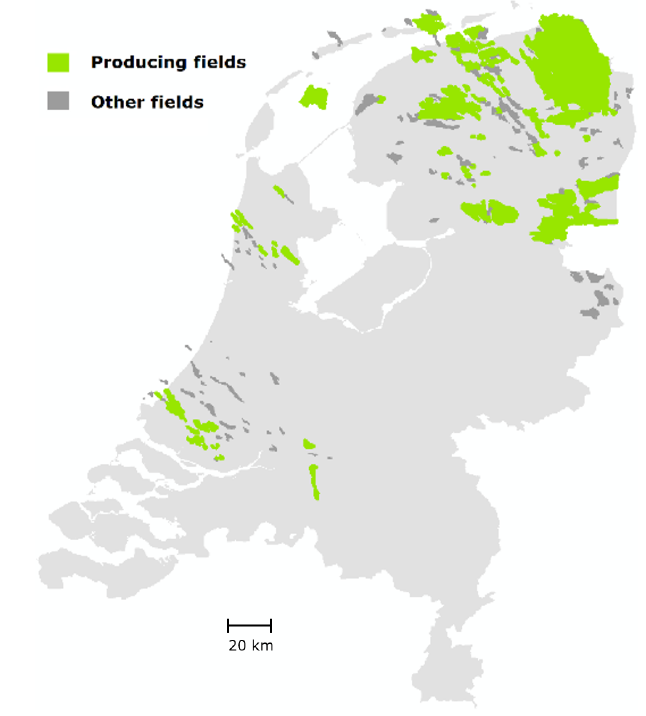
Figure 1. Gas fields in the Netherlands.